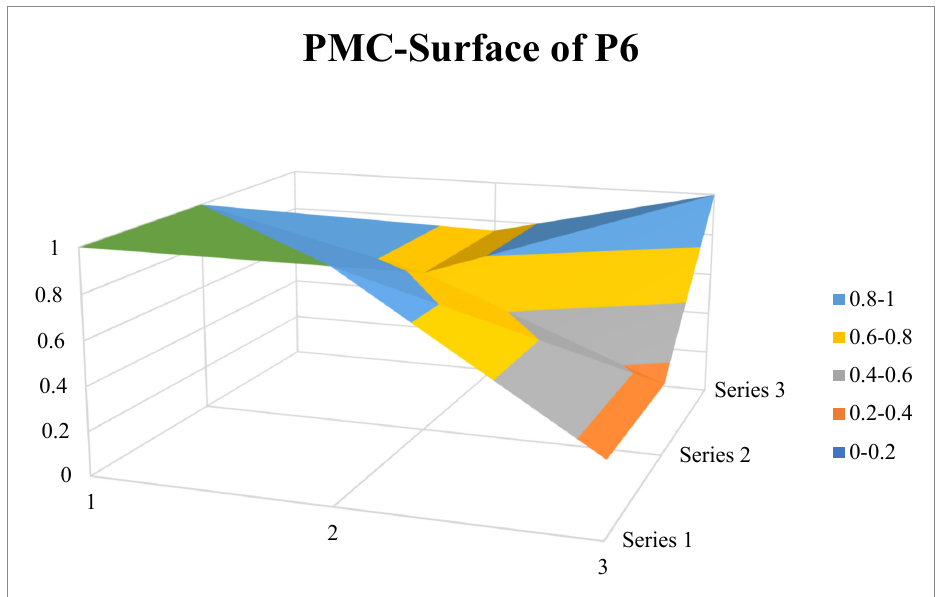
Figure 9. PMC-Surface of P 5.